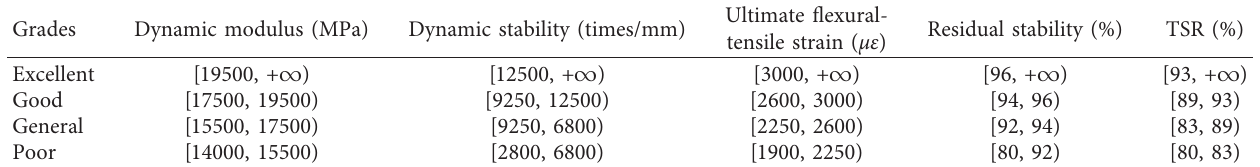
Table 4: Classification standard of admixture high modulus asphalt